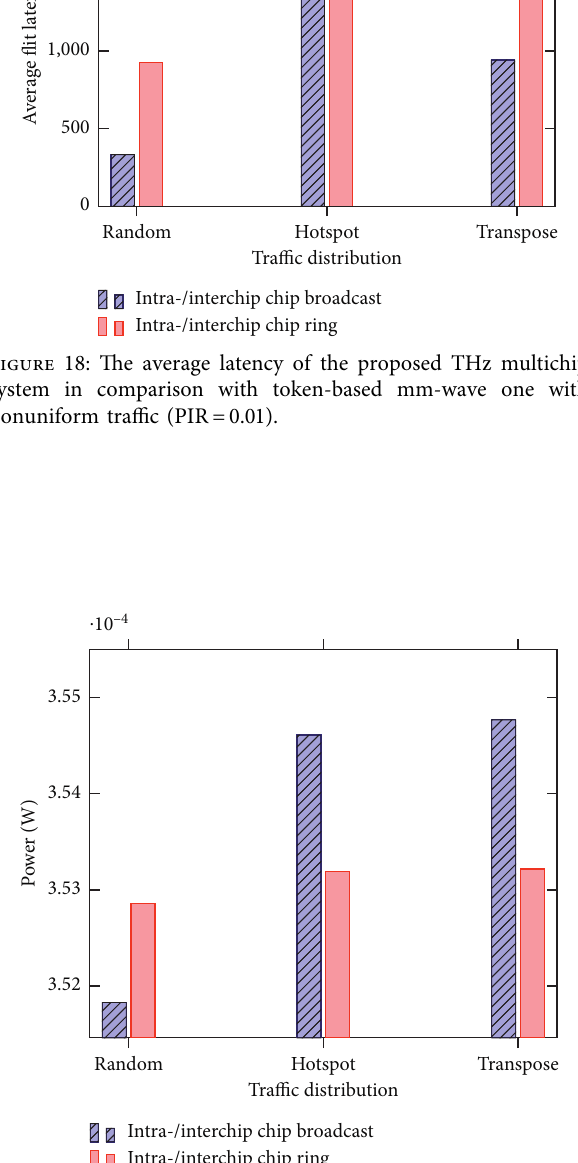
Figure 17: The throughput of the proposed THz multichip system in comparison with the token-based mm-wave one with nonuniform traffic (PIR � 0.01).